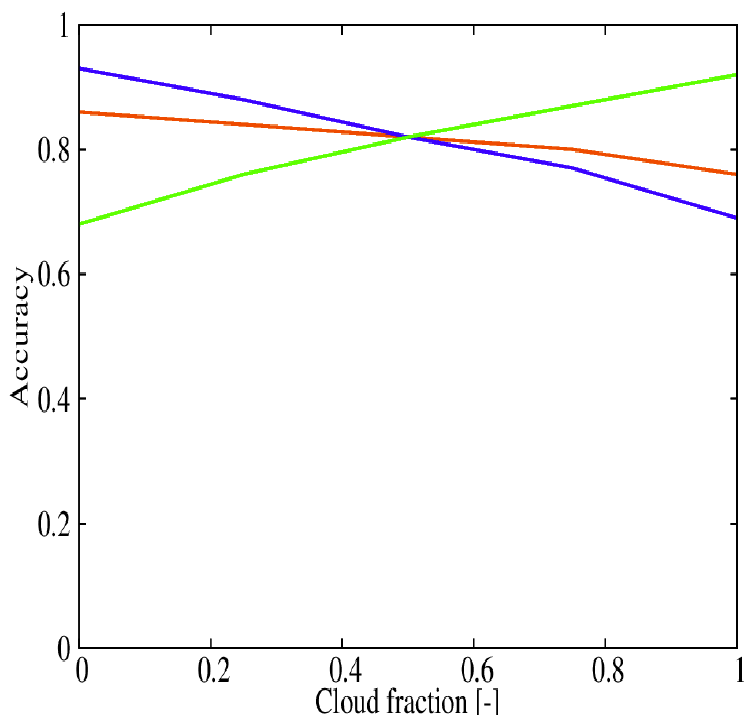
Figure 8. Accuracy of the optimal GOES-16 clear sky product as a function of a cloud fraction threshold .